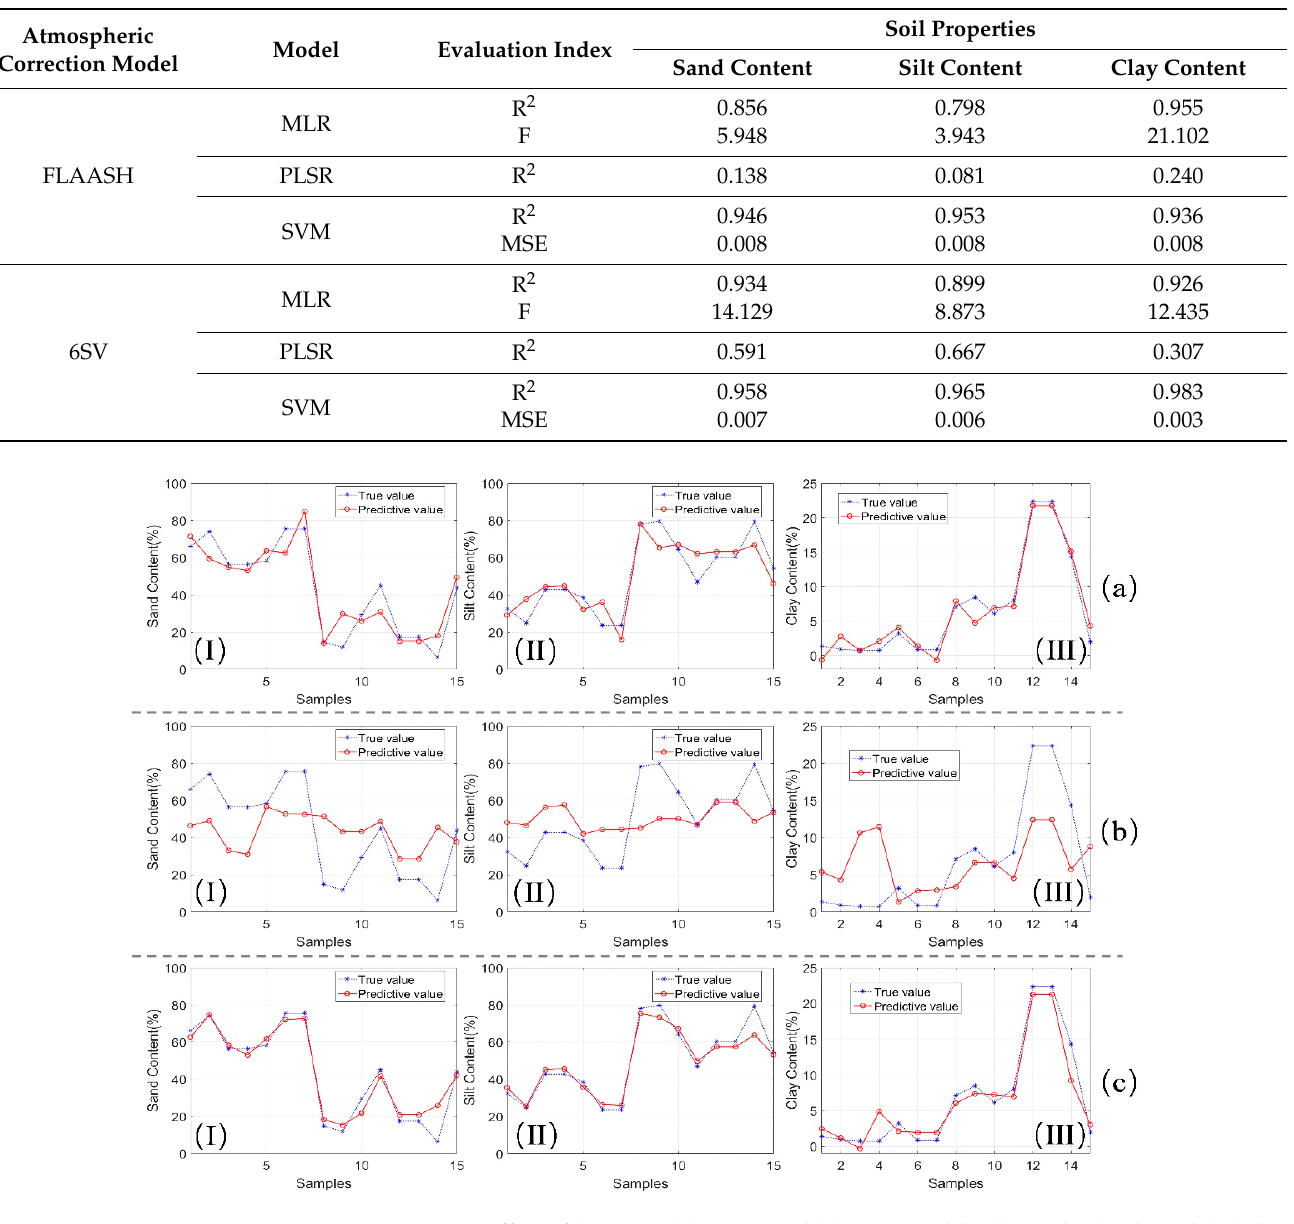
Figure 10. Fitting effect of ( a ) MLR, ( b ) PLSR, and ( c ) SVM models, (I) sand, (II) silt, and (III) clay content predicted, and true values using FLAASH atmospheric correction surface reflectance data.